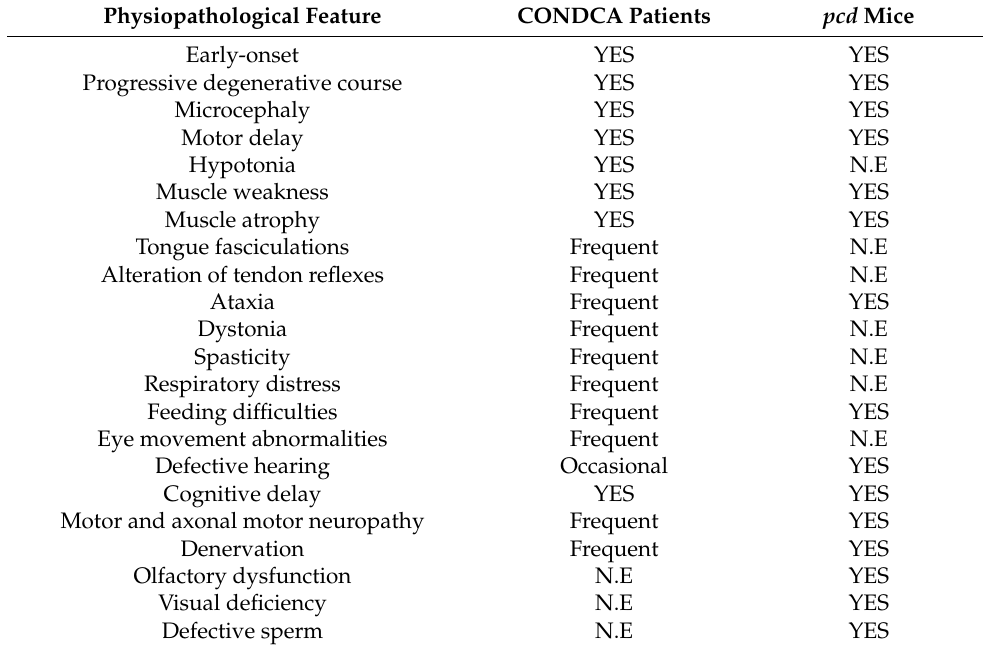
Table 4. Comparison of pathological findings between CONDCA patients and the pcd mutant mouse. N.E: Not